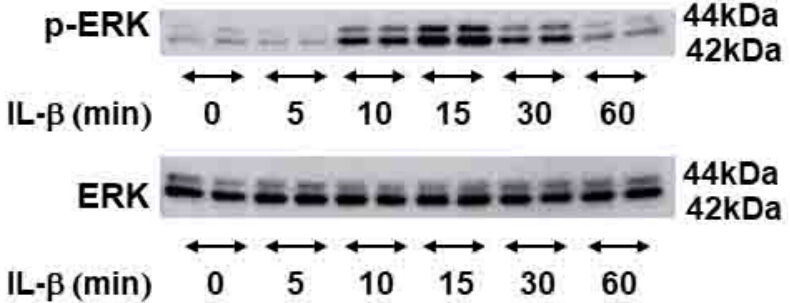
Figure 4. IL-1 β induced phosphorylation of ERK in OUMS-27 cells. ERK and phosphor-ERK proteins were detected by Western blotting analysis. OUMS-27 cells were treated with IL-1 β and subjected to Western blot at various time points (minutes) as indicated. Data shown are for experiments performed in duplicates.